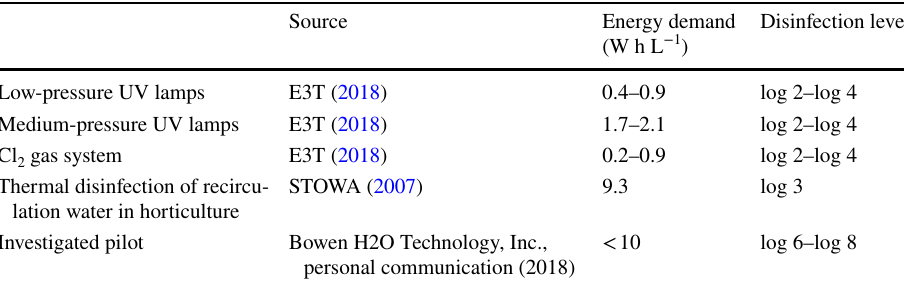
Table 3 Comparison of energy demand for water disinfection by UV irradiation, chlorination and thermal